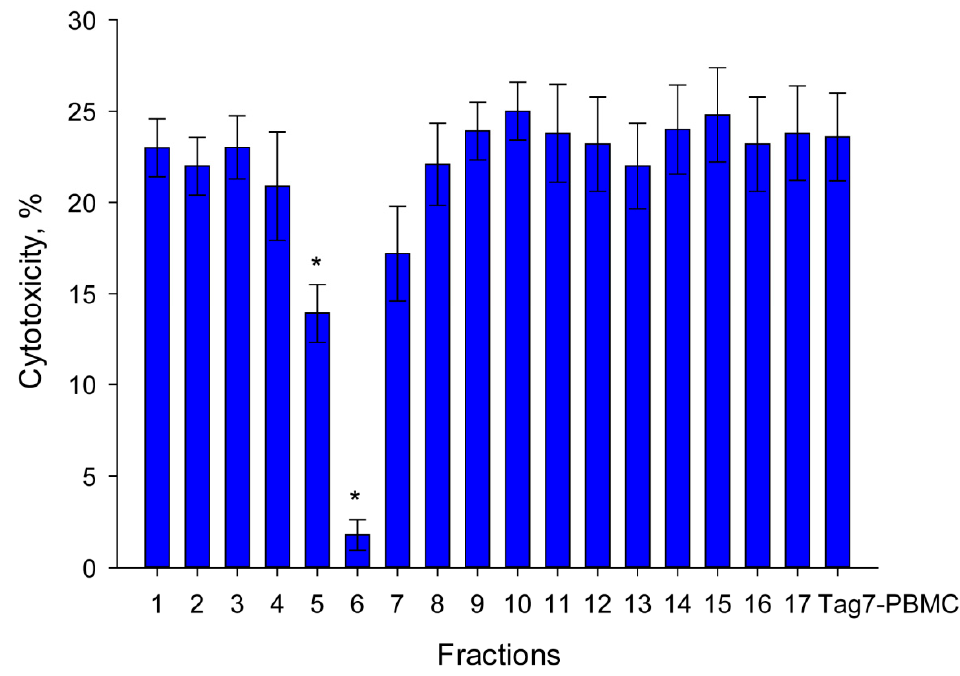
Figure 1. Inhibition by peptide fractions after hydrolysis and separation by chromatography using a Superdex Peptide column of lymphocyte activation for 6 days by Tag7 protein. An aliquot of each fraction was added to PBMC 30 min prior to the addition of Tag7 protein. The cytotoxic activity of lymphocytes was measured against K562 cells (one-way ANOVA, p -value: * < 0.05 vs. Tag7-PBMC). Only 1 (No. 6) of 17 analyzed fractions contained a peptide that blocked the induction of PBMC cytotoxic activity (Figure 1). Using MALDI analysis, an 8-mer peptide of this fraction that corresponded to the N-terminal amino acid sequence (amino acids 77–86) was identified.